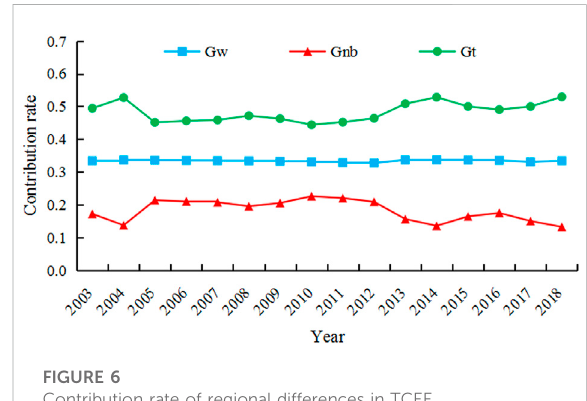
FIGURE 6 Contribution rate of regional differences in